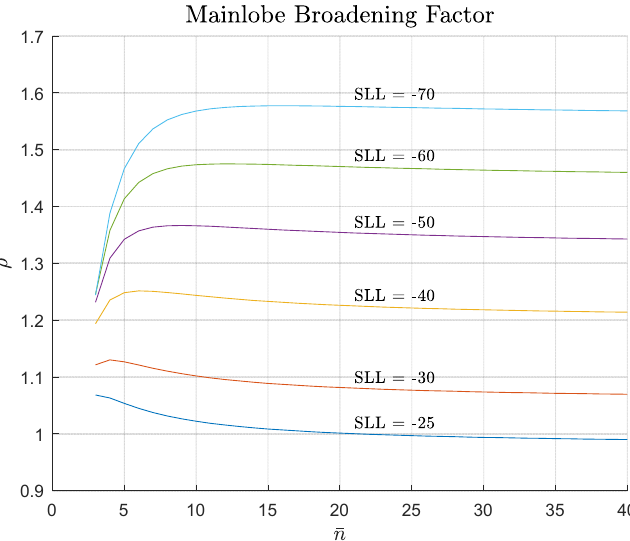
Figure 12. Mainlobe broadening factor for various 𝑆𝐿𝐿 and 𝑛(cid:3364) values.